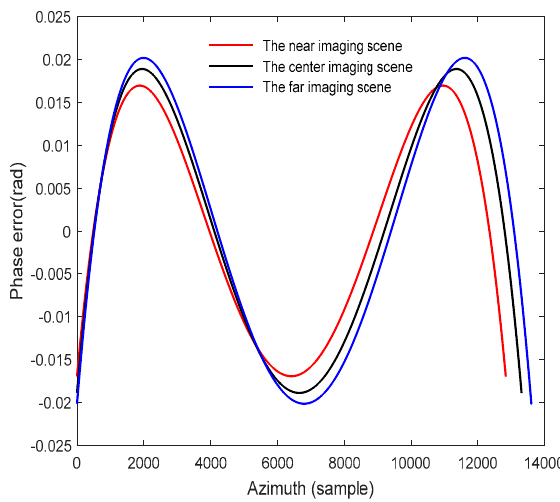
Figure 6. The phase errors introduced by the approximate polynomial fitting of the SAR slant range.